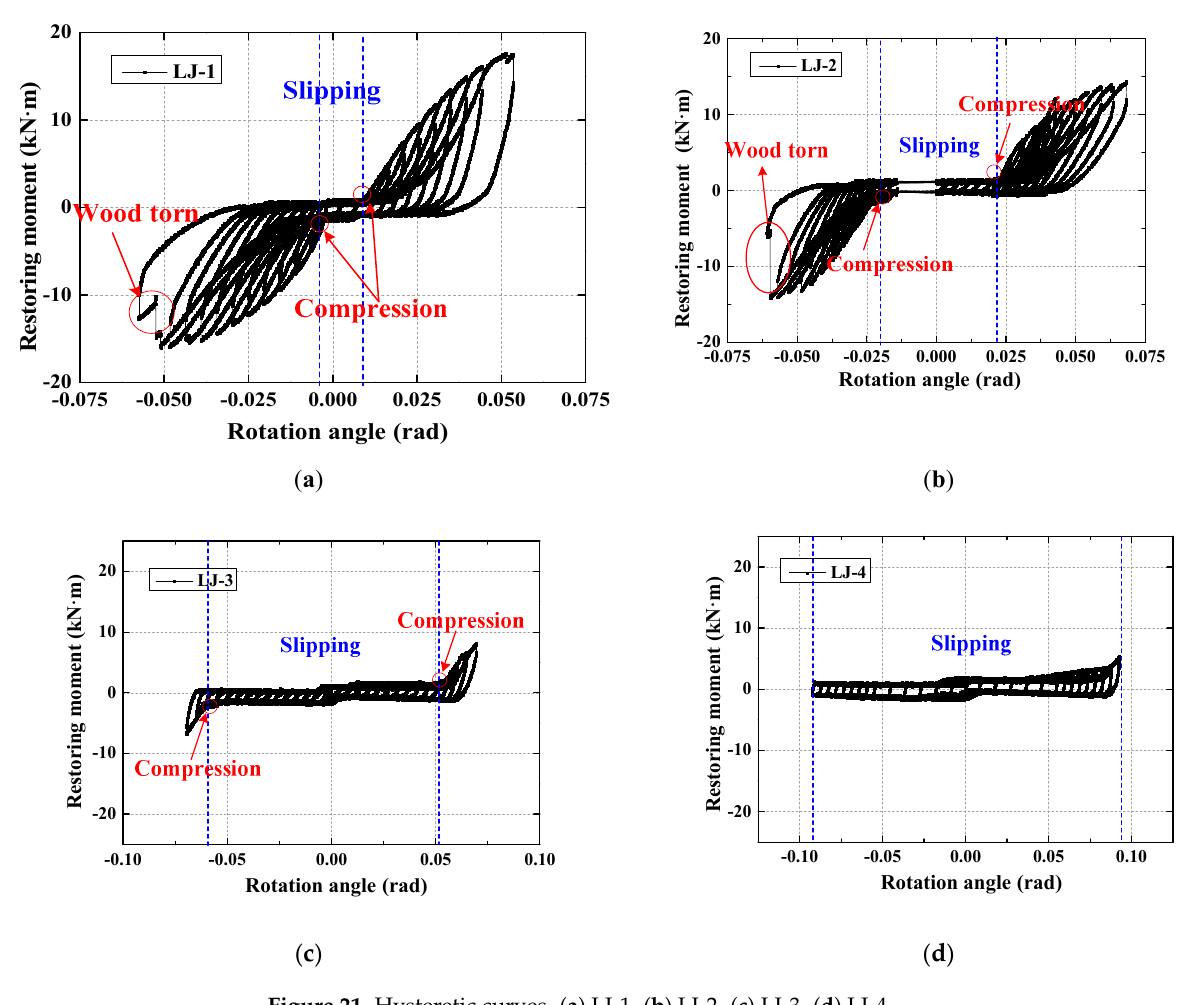
Figure 21. Hysteretic curves. ( a ) LJ-1. ( b ) LJ-2. ( c ) LJ-3. ( d ) LJ-4 . Table 2. The changing of initial rotation angles, the maximum restoring moment and the decline ratio of maximum restoring moment.